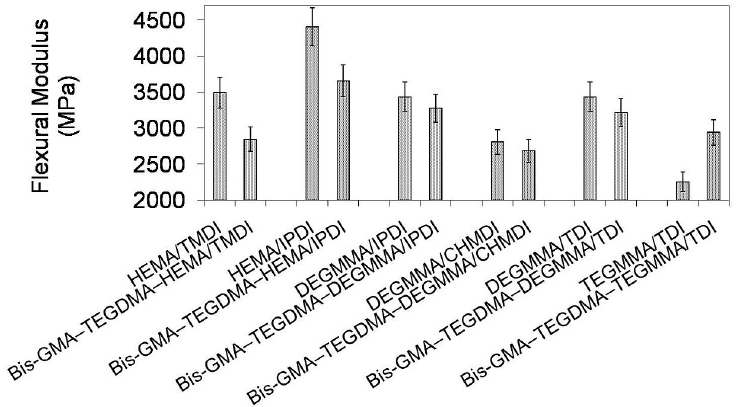
Figure 11. The flexural modulus of homopolymers and copolymers composed of UDMA, Bis-GMA and